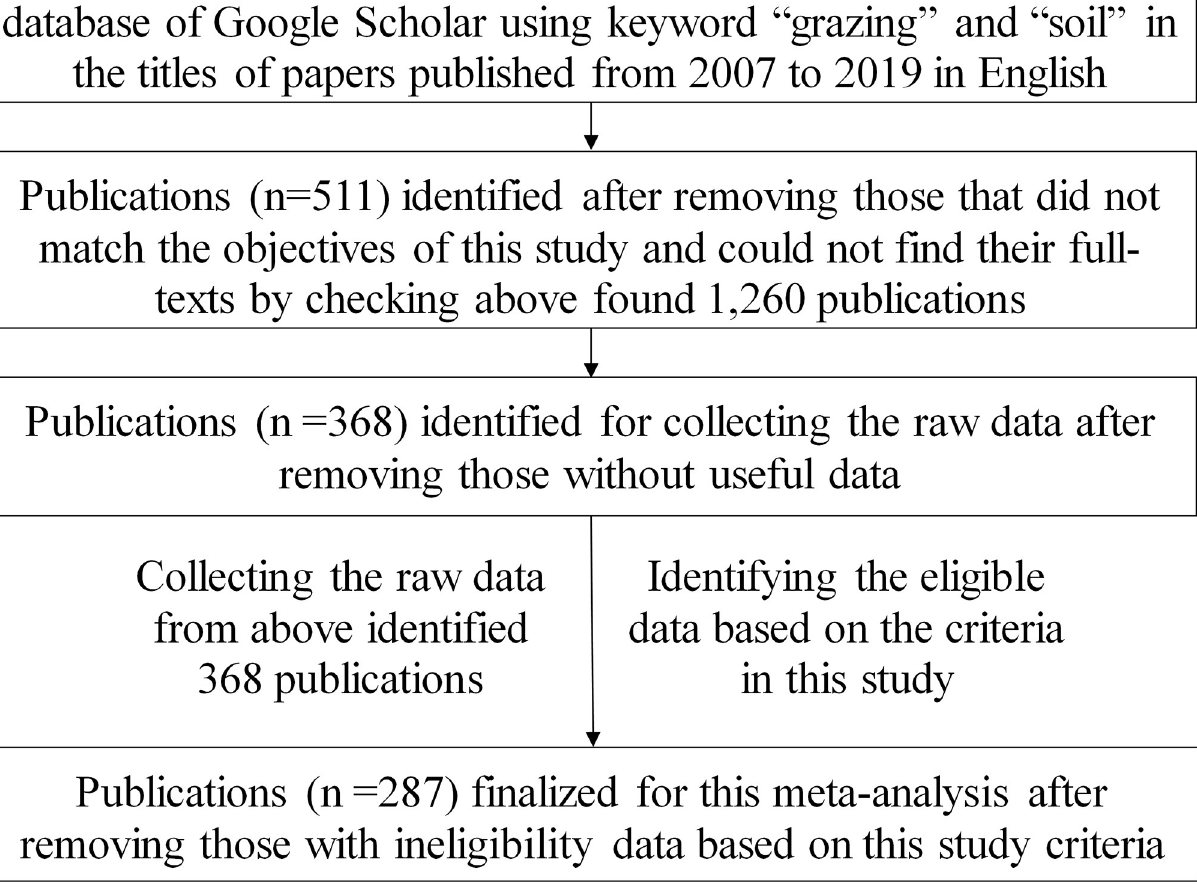
PLOS ONE | https://doi.org/10.1371/journal.pone.0236638 August 7,